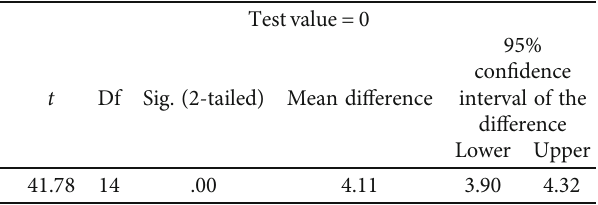
Table 6: One-sample test of the